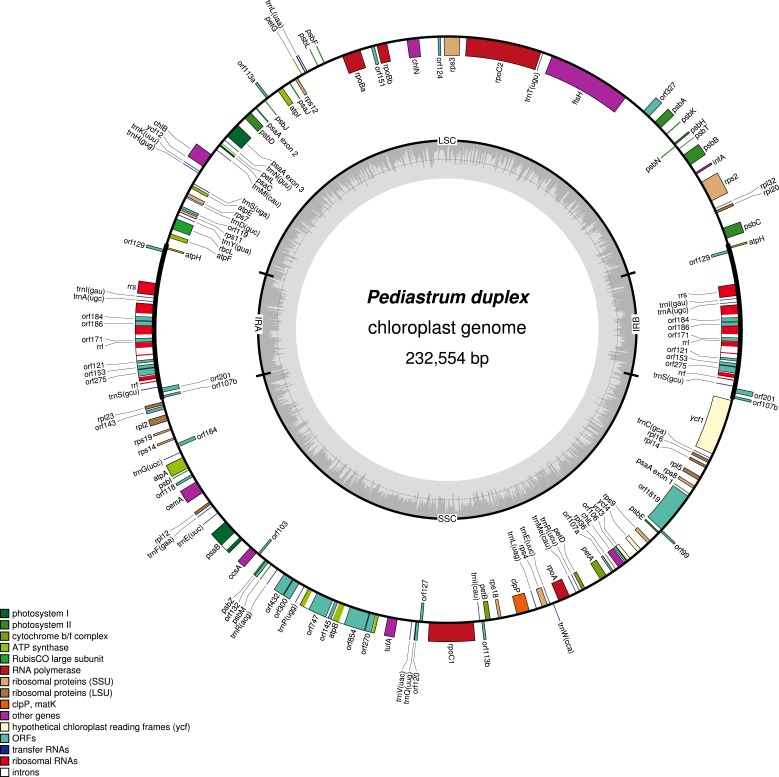
Gene map of Pediastrum duplex plastome (KY114064).The inverted repeats (IRA and IRB) which separate the genome into two single copy regions are indicated on the inner circle along with the nucleotide content (G/C dark grey, A/T light grey). Genes shown on the outside of the outer circle are transcribed clockwise and those on the inside counter clockwise. Gene boxes are color coded by functional group as shown in the key.